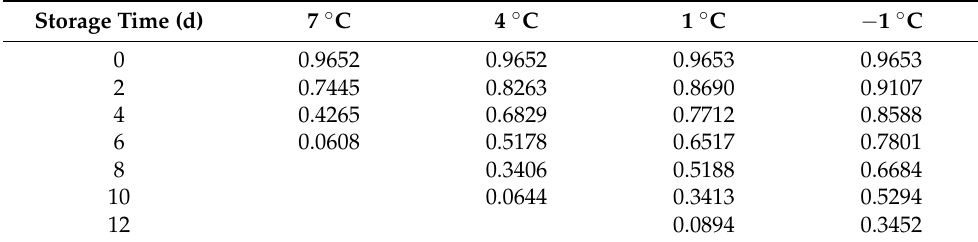
Table 1. Comprehensive quality change of pork at each temperature during storage.